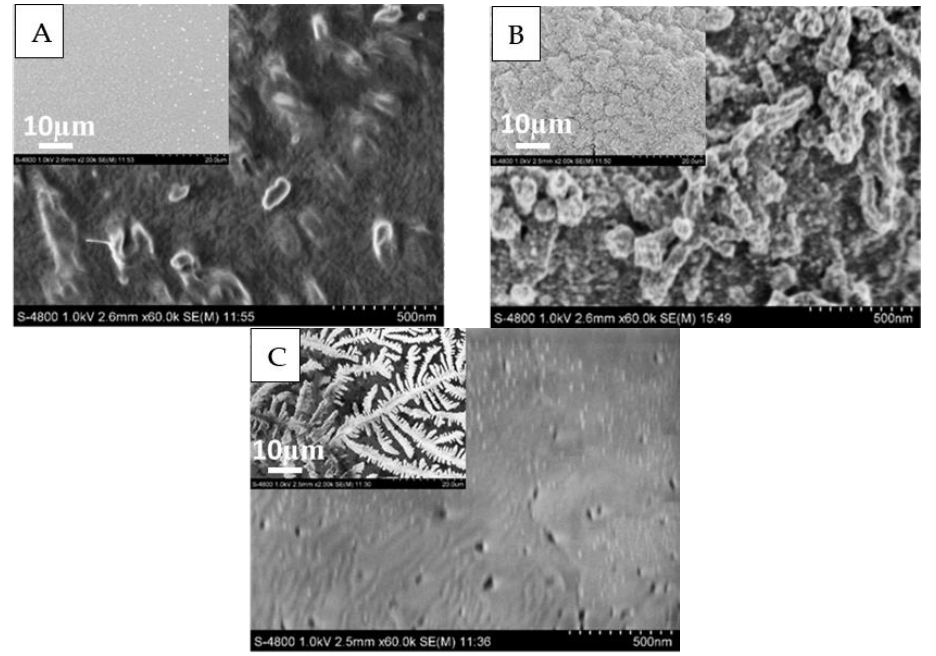
Figure 7. The SEM of PEDOT ( A ) one-step overoxidized PEDOT ( B ) and double-step overoxidized PEDOT ( C ) films with the magnification of 2 K and 60 K.